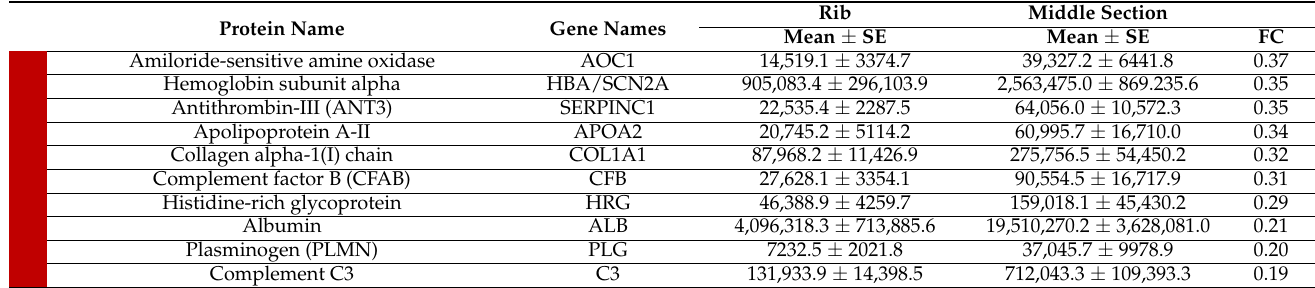
Proteins overexpressed in rib and middle section of antler are indicated in the table by green and red color, respectively.